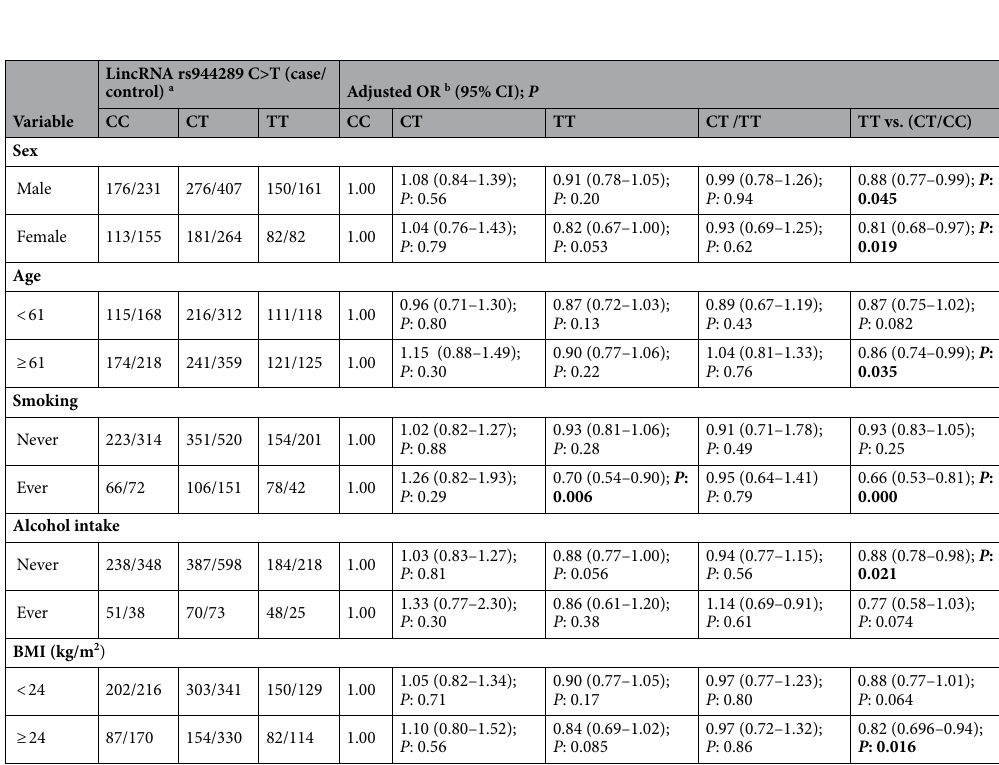
Table 4. Stratified analyses between LincRNA rs944289 C>T polymorphism and CRC risk by gender, age, BMI, smoking and alcohol intake. a For ICAM-1 rs944289 C>T, the genotyping was successful in 980 (97.71%) CRC cases, and 1300 (99.77%) controls; b Adjusted for multiple comparisons [age, gender, BMI, smoking status and alcohol intake (besides stratified factors accordingly)] in a logistic regression